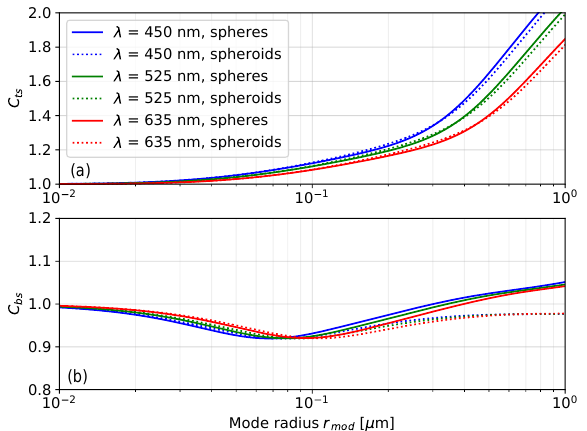
Figure 10. Modeled correction factors C ts for total scattering (a) and C bs for hemispheric backscattering (b) of an Aurora 3000 neph- elometer as a function of particle size. For details, see